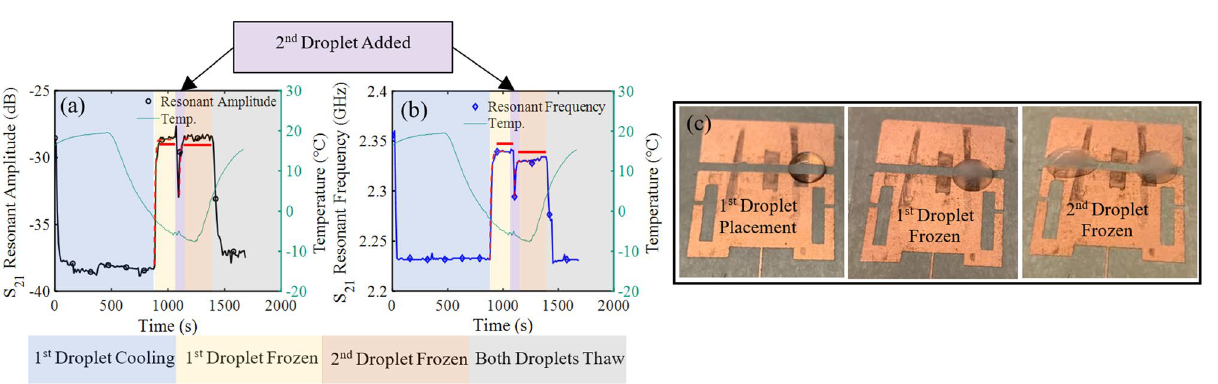
Figure 10. ( a ) Resonant amplitude and ( b ) resonant frequency recorded during the increased iced surface area experiments, and ( c ) the pictured droplet placements on the antenna. Within the plots, the dotted red line is an exponential curve fit and the bold red line is the time averaged data